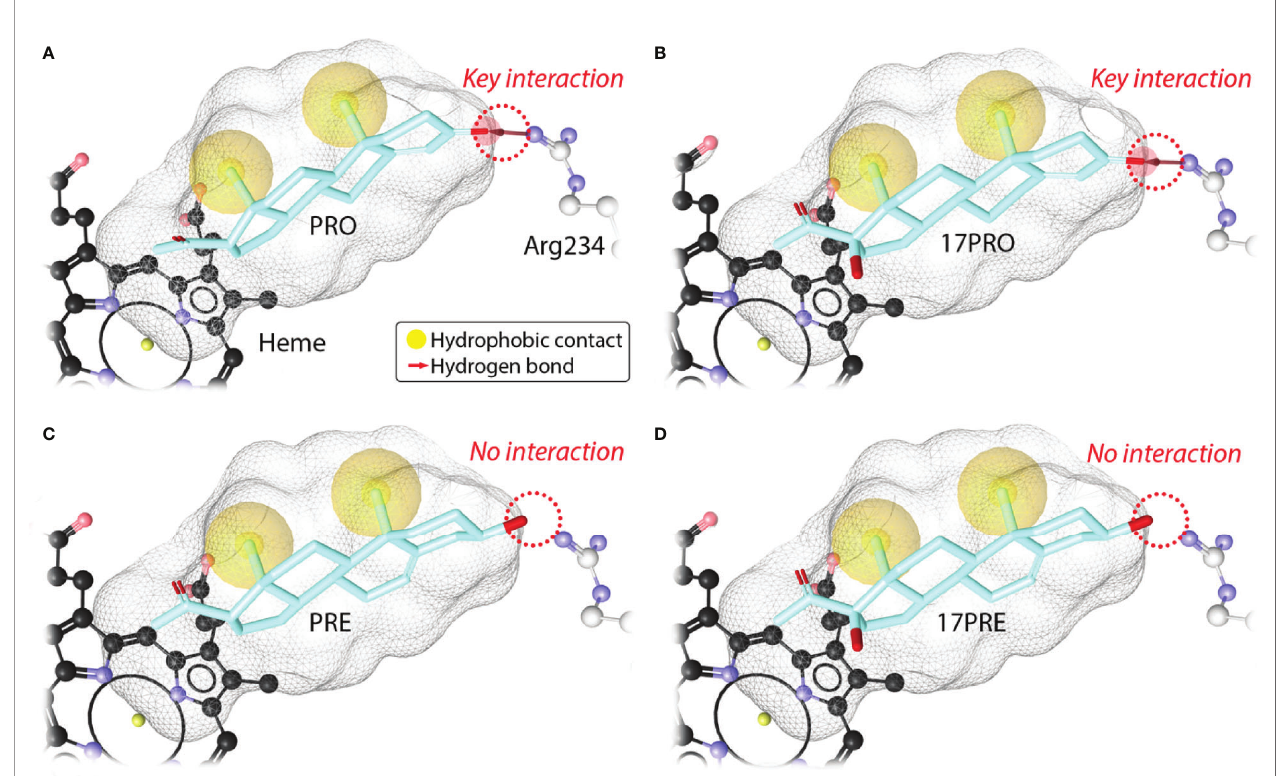
FIGURE 3 | Substrate binding to the active site of CYP21A2. Progesterone binding mode from X-ray structure (PDB: 4Y8W) ( A , PRO). Suggested binding modes of 17 a -hydroxyprogesterone ( B , 17PRO), pregnenolone ( C , PRE) and 17 a -hydroxypregnenolone ( D , 17PRE) obtained from docking. Active substrates (A, B) form the key interaction to Arg234. Inactive substrates (C, D) do not show this interaction, which makes productive binding highly